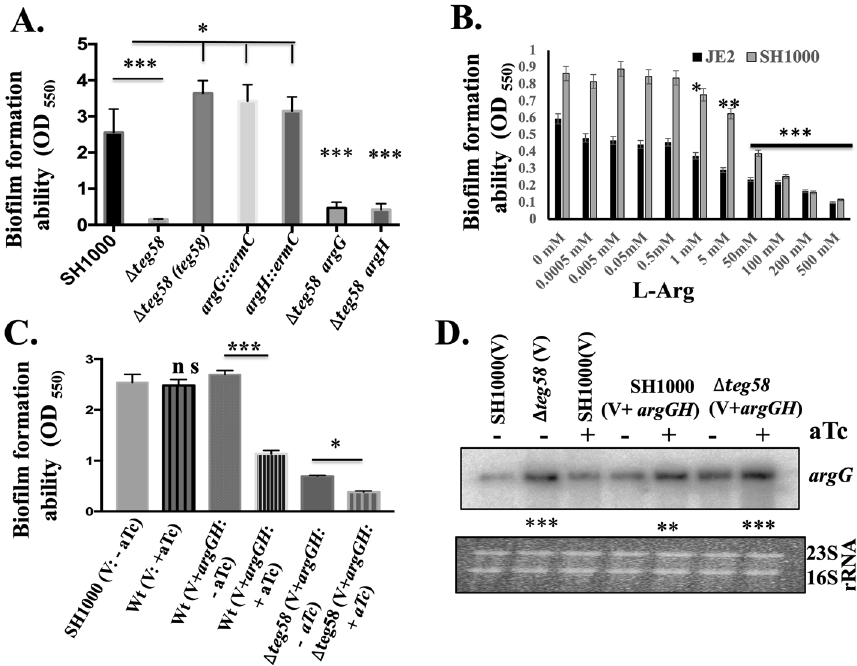
Figure 5. Inhibition of biofilm formation by l-arginine. ( A ) Static biofilm formation for various strains in complete CDM containing 1% glucose for 24 h in a microtiter plate (Costar, USA). ( B ) Biofilm formation for various strains for 24 h in complete CDM containing 1% glucose and various concentrations of exogenous l-arginine in a microtiter plate format. ( C ) Biofilm formation for various strains as indicated in TSB supplemented with 0.25% glucose for 24 h in a microtiter plate under induced (+ ATc) (500 ng/ ml) and uninduced (-ATc) conditions. V represents pALC2073 as the vector control; V + argGH , represents pALC2073 with argGH including ribosome binding site cloned under tetO -inducible promoter; ATc stands anhydrotetracycline which is inducer for the pALC2073 system. ( D ) Transcript analysis of 10 μg of total cellular RNAs isolated from cultures in ( C ) under various conditions and probed with argG probe. “+” and “−” indicate the inducible and uninducible conditions. The relative band intensity of various lanes was determined by Image J software (NIH) and the statistically significant was calculated considering the wild type as 100. Original blot is presented in Supplementary Material files Fig. X4. Means and standard deviations from triplicate experiments are shown. Student t -test (* P < 0.05, ** P < 0.01; *** or ****P < 0.001) and “n.s” indicate “not